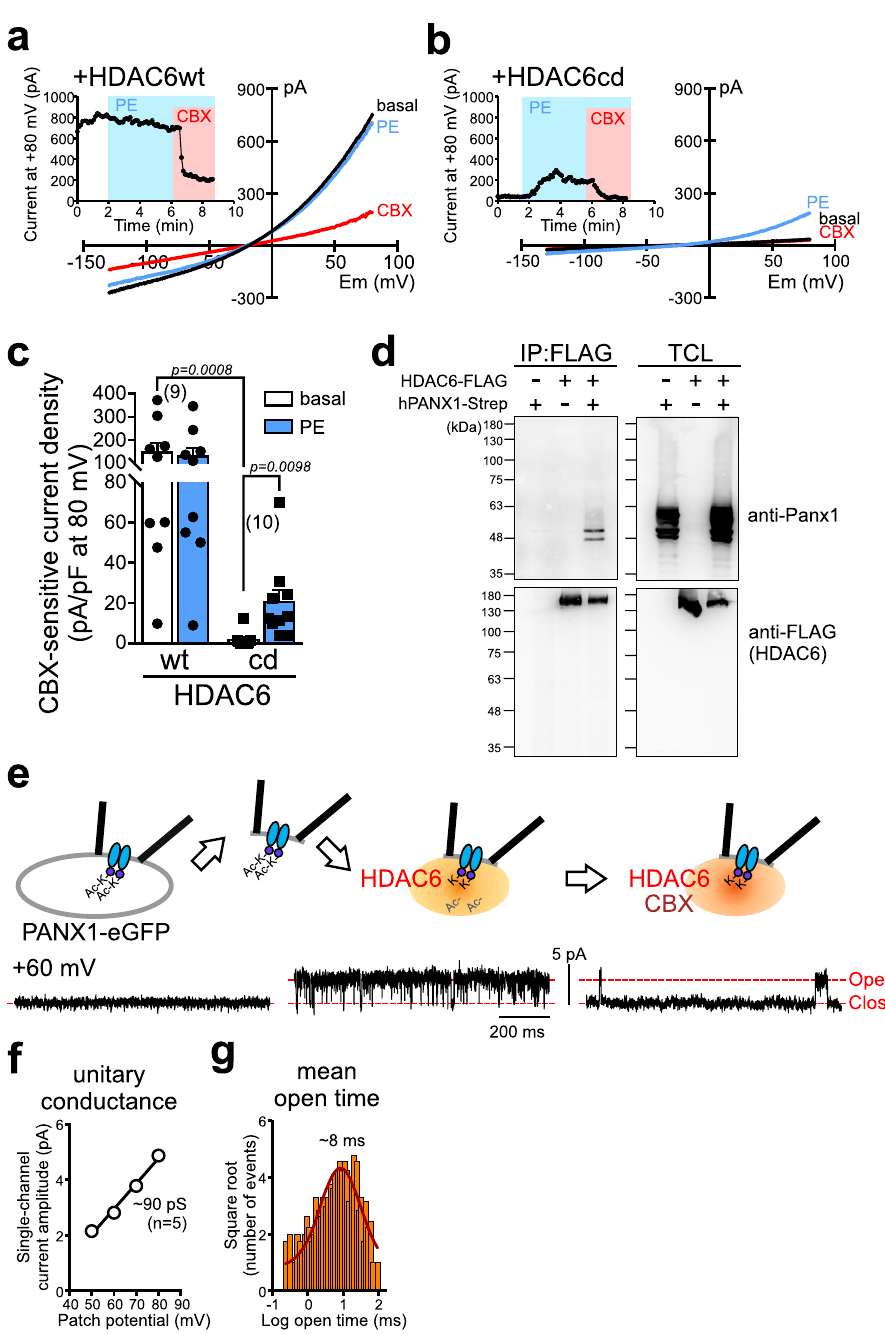
Fig. 5 HDAC6 is suf fi cient to activate PANX1, even in cell-free conditions. a, b Basal and PE-stimulated whole-cell currents in α 1D-AR/hPANX1(TEV)- transfected HEK293T cells co-expressing wild-type ( a ) or catalytically inactive ( b ) forms of HDAC6. c Summary data (mean ± s.e.m) showing that the active form of HDAC6 increased basal PANX1 current and occluded PE effects. n = 9 or 10 cells examined over 3 independent experiments. Two-way ANOVA (F 1,17 = 18.07, p = 0.0005) with Bonferroni ’ s multiple comparisons test ( p values from comparisons are shown). d Co-immunoprecipitation showing interaction between HDAC6 and hPANX1 (from n = 3). FLAG-tagged HDAC6 and strep-tag-conjugated PANX1 were heterologously expressed in HEK293T cells. PANX1 proteins were co-immunoprecipitated with FLAG-tagged HDAC6. TCL total cell lysate. e Effect of HDAC6 and CBX on GFP-tagged hPANX1 channel recorded in inside-out patch con fi guration. f, g Averaged unitary I – V ( f ) and a representative open time distribution ( g ) for HDAC6- activated PANX1 channels in inside-out patches ( γ = 89.5 ± 1.8 pS, mean open time = 8.3 ± 1.3 ms, n = 5 independent membrane patches; mean ± s.e.m). PE phenylephrine, CBX